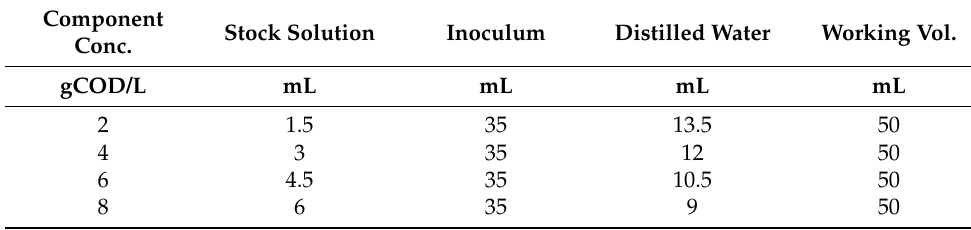
Table 3. Constituent of an HBT for the respective test component concentration. Component Stock Solution Inoculum Distilled Water Working Vol. Conc. gCOD/L mL mL mL